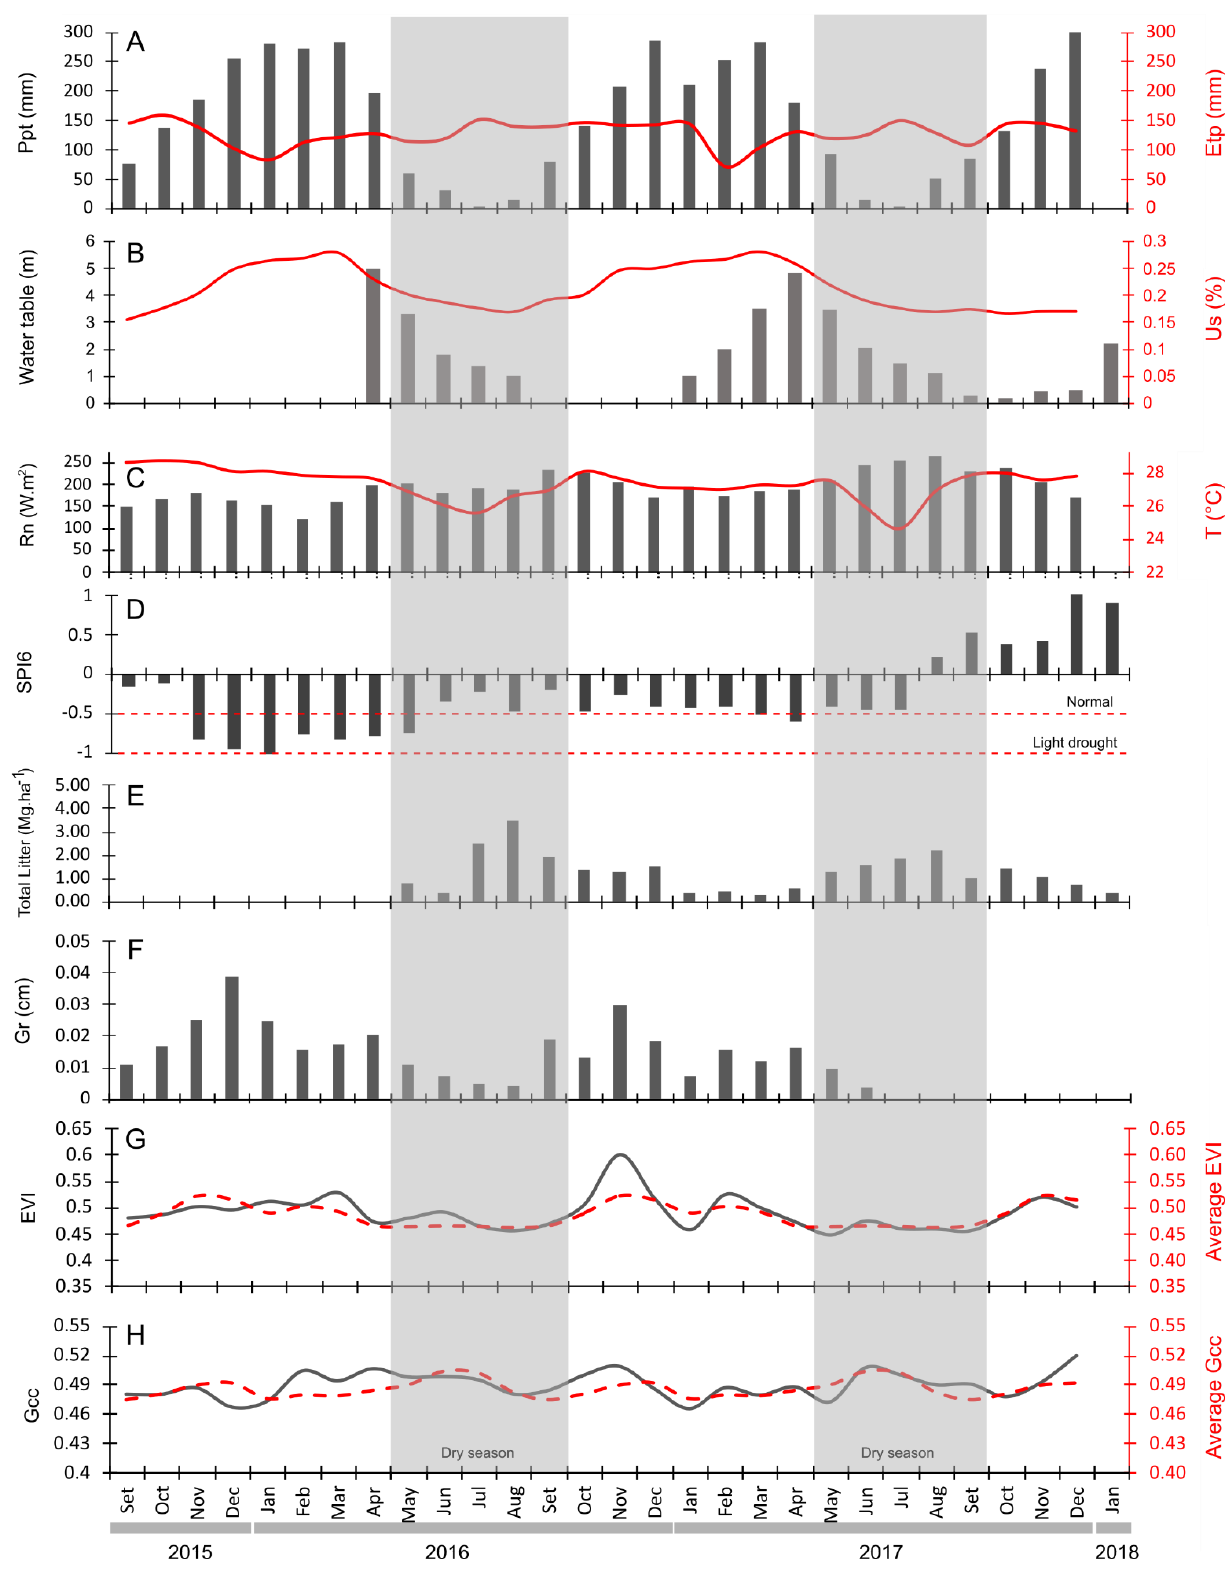
Figure 2 . Temporal pattern of variables for the study series, RJA site. ( A ) Precipitation in black and evapotranspiration in red; ( B ) Water table depth in black and soil moisture in red; ( C ) Net radiation in black and temperature in red; ( D ) SPI6 index; ( E ) Total litter; ( F ) Stem growth; ( G ) EVI index in black and long-term EVI index in red; ( H ) Gcc index in black and long-term Gcc index in